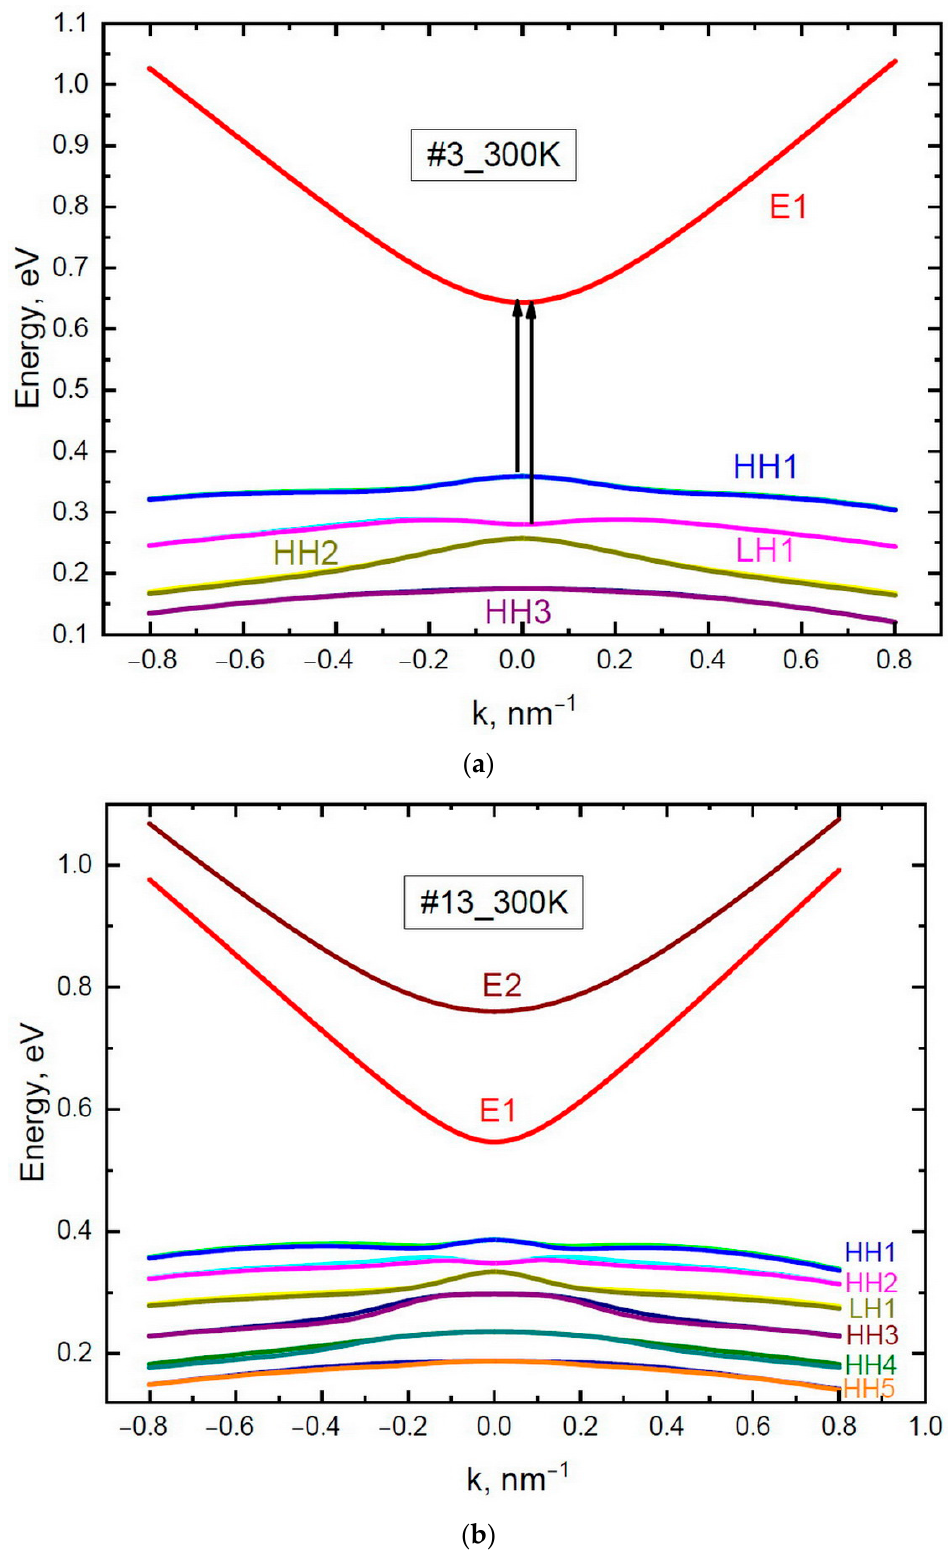
Figure 4. Band structure Hg 1-x Cd x Te/Hg 1 - y Cd y Te QW with different well width values: ( a ) sample #3 (well width 3.7 nm); ( b ) sample #13 (well width 8.1 nm). E1–red; E2–brown; HH1–blue; HH2–pink for #3 and yellow for #13; HH3–brown; HH4–green; HH5–orange; LH1–yellow for #3 and pink for #13. The arrows represent the allowed electronic transition.